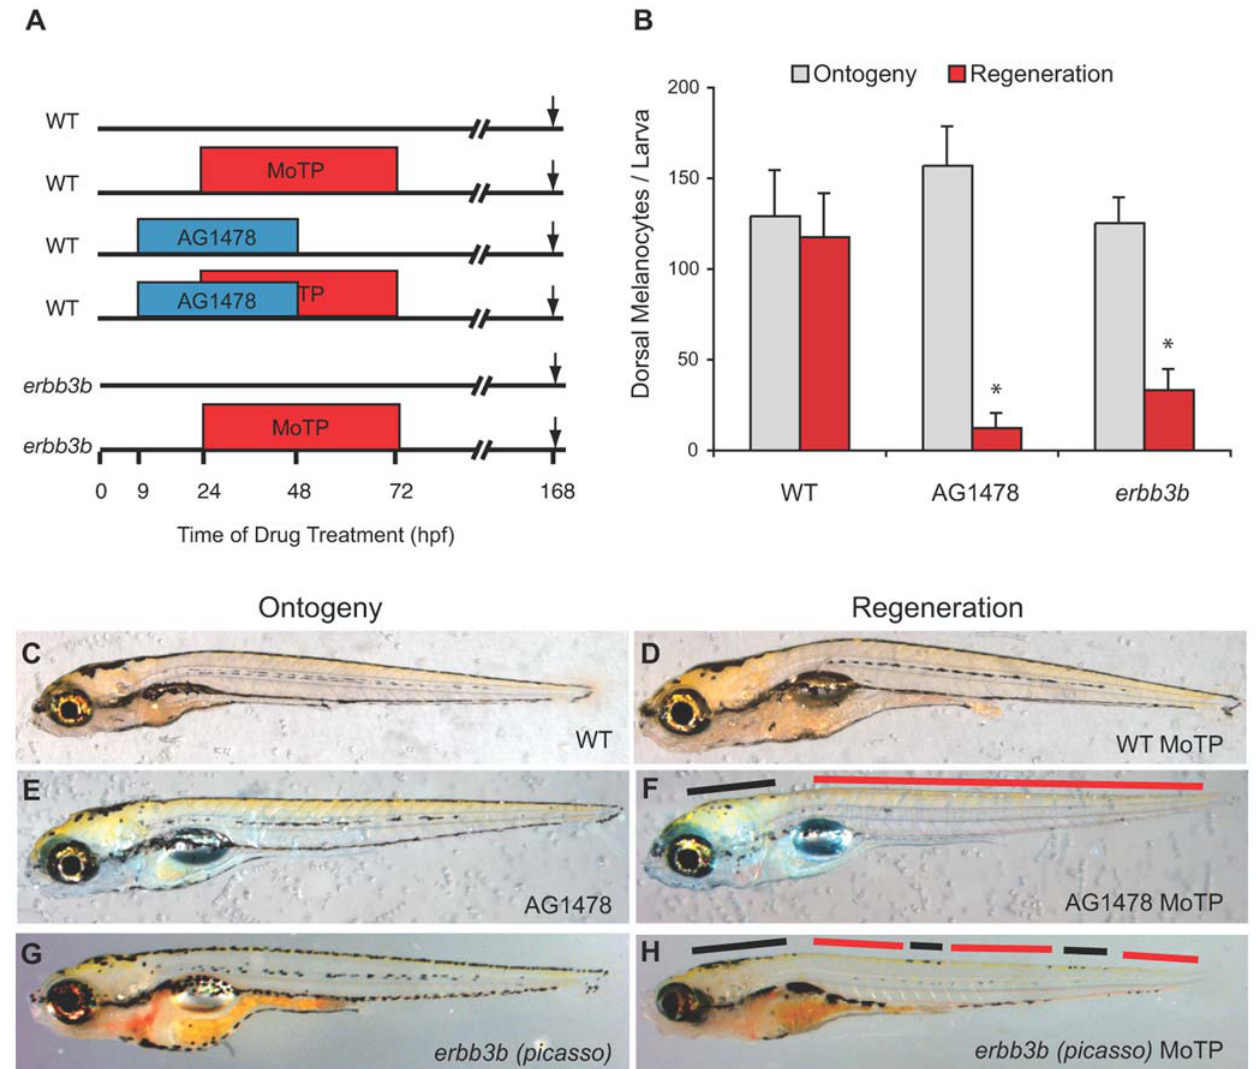
Figure 1. ErbB signaling is required for larval melanocyte regeneration. (A) Cartoon of drug treatment timeline for assaying melanocyte ontogeny and regeneration. Arrow indicates when embryos were collected for photos and melanocyte counts, in this case at 168 hpf. (B) Quantitation of average dorsal melanocytes from somites 1–26 for each treatment in (A) for melanocyte ontogeny (gray) and melanocyte regeneration (red). Error bars represent standard deviation, * represents P , 0.05 (Student t-test, N=10). Photos of representative larvae at 168 hpf for ontogeny (C, E, G) and regeneration (D, F, H). WT larvae regenerate nearly completely (compare D to C). WT treated with AG1478 (E, F) and erbb3b mutants (G, H) largely fail to regenerate but have normal ontogenetic number of melanocytes. A few regeneration melanocytes are observed in the head and sporadically in parts of the trunk (black bars in F and H) but are mostly absent throughout the trunk (red bars in F and H).